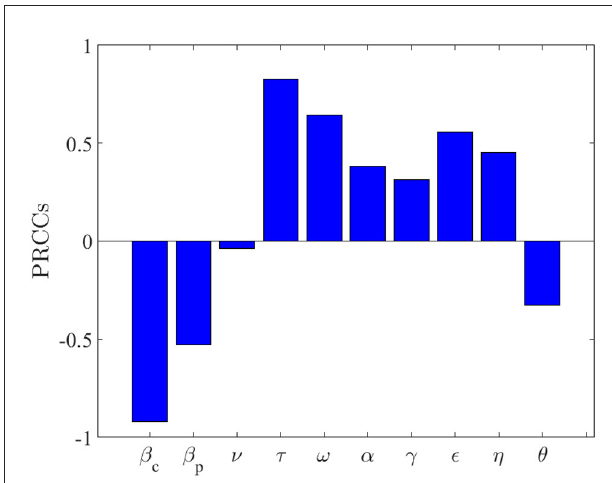
FIGURE5 Partial rank correlation coefficients (PRCCs) showing the effects of the model parameters on the response variable (which in our case is the crime population as a function of time). The baseline values of the parameters used are given in Tables 3, 4.